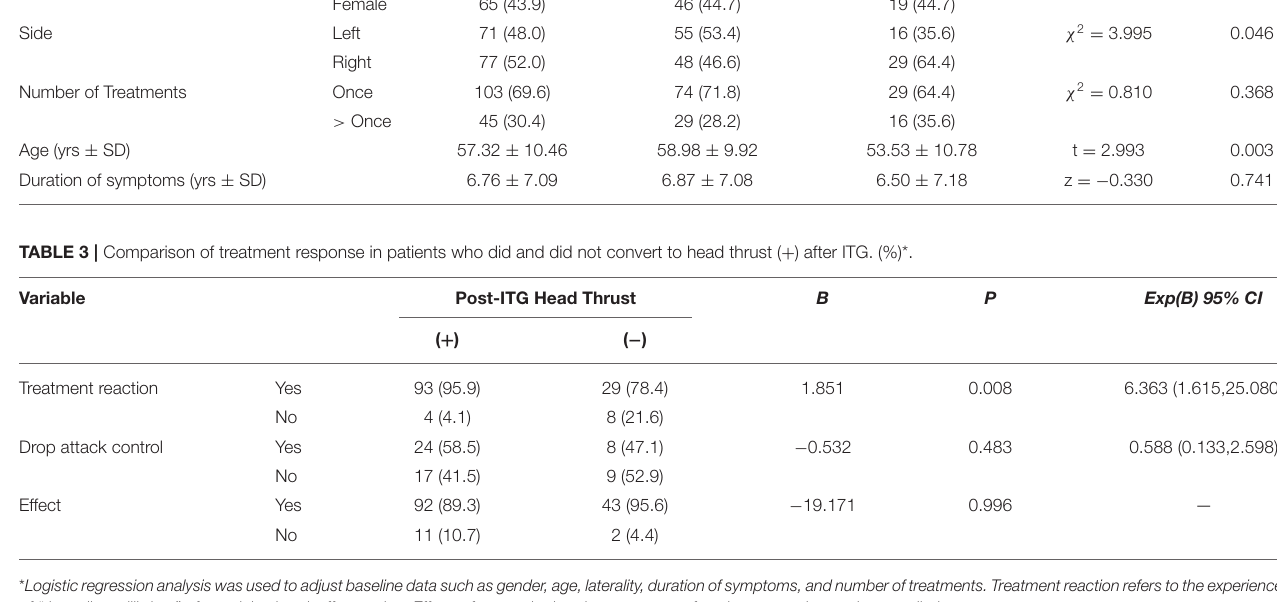
score) between the converted vs. non-converted HTT